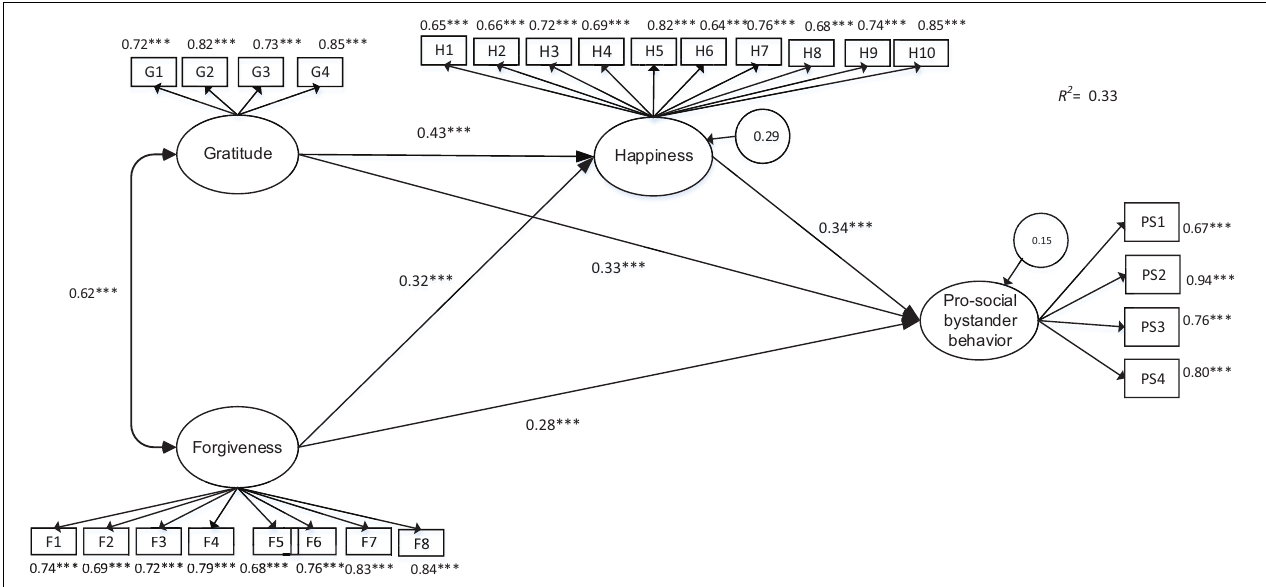
FIGURE 2 | Results of the structural model of the relations between forgiveness, gratitude, happiness, and prosocial bystander behavior. Standardized coefficients are